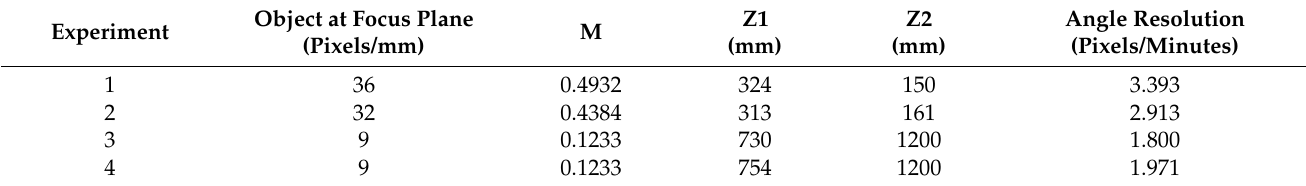
Table 1. Comparison of measurement parameters and calculated angle resolutions.